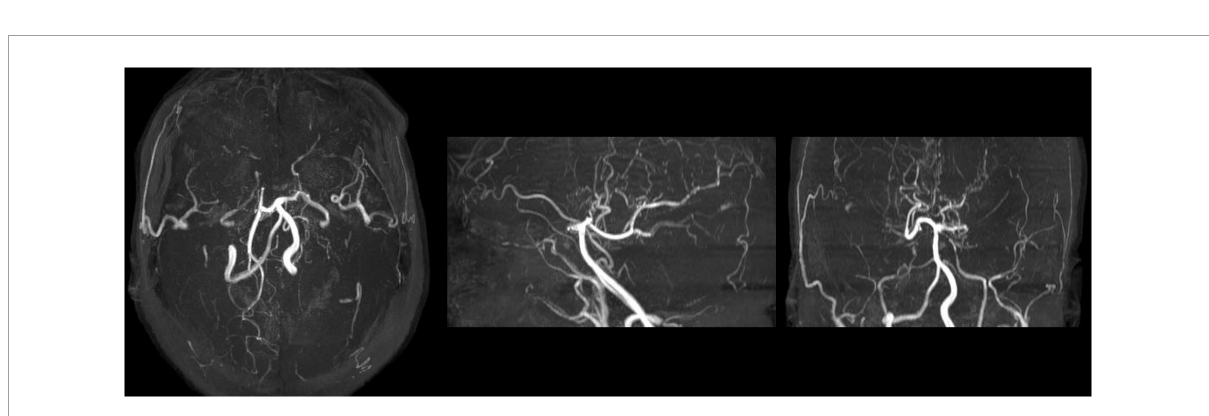
FIGURE3 Maximum Intensity Projection sequence of MRA scan after neurological symptoms. MRA scan showed distal internal carotid artery occlusion, bilateral anterior and middle cerebral arteries occlusion, abundant and disordered collateral circulation at the circle of basal artery and bilateral basal ganglia, considered moyamoya